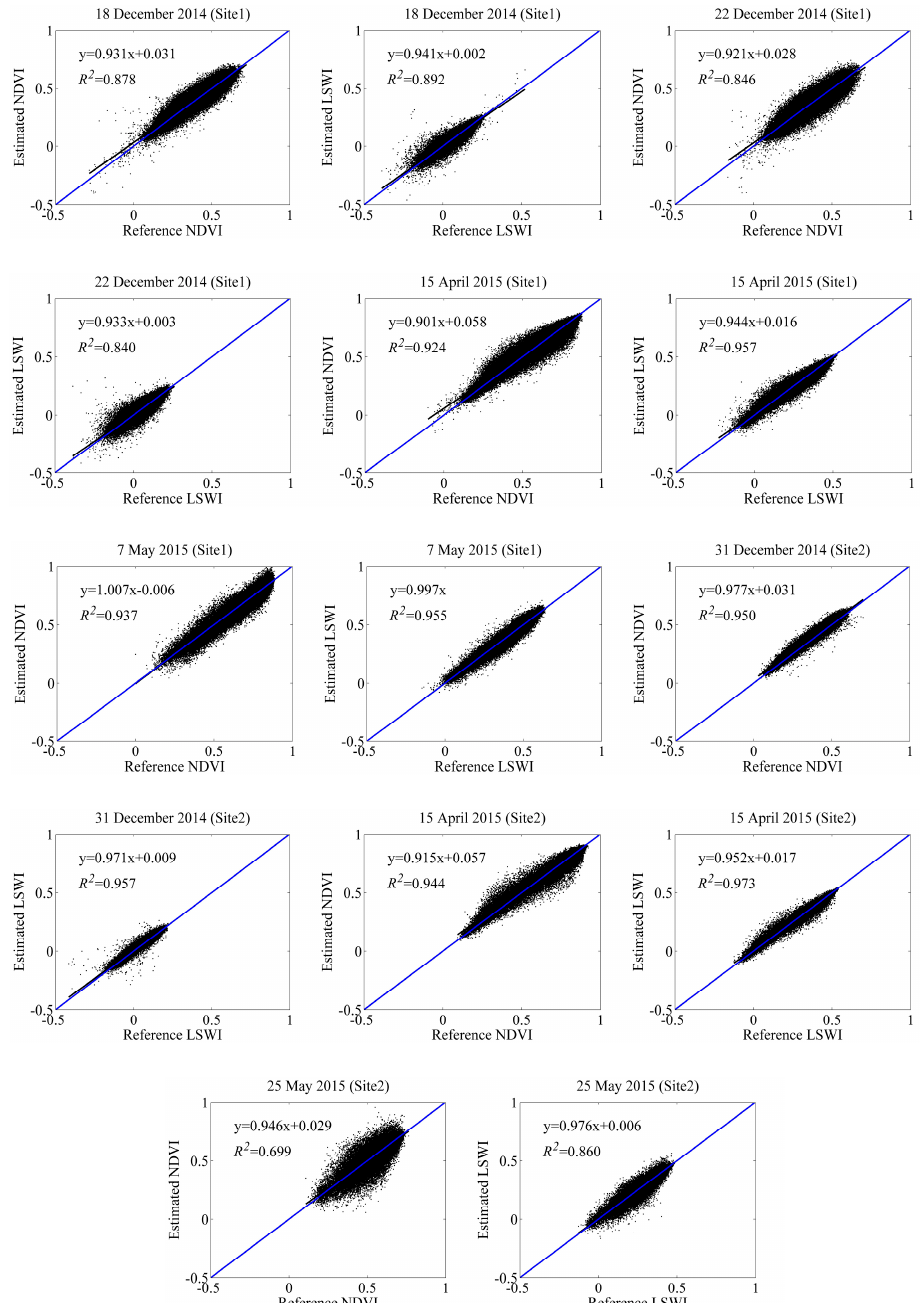
Figure 5. Comparison between the observed and predicted PROBA-V 100-m NDVI and LSWI. The 1:1 line is blue, and the regression line is